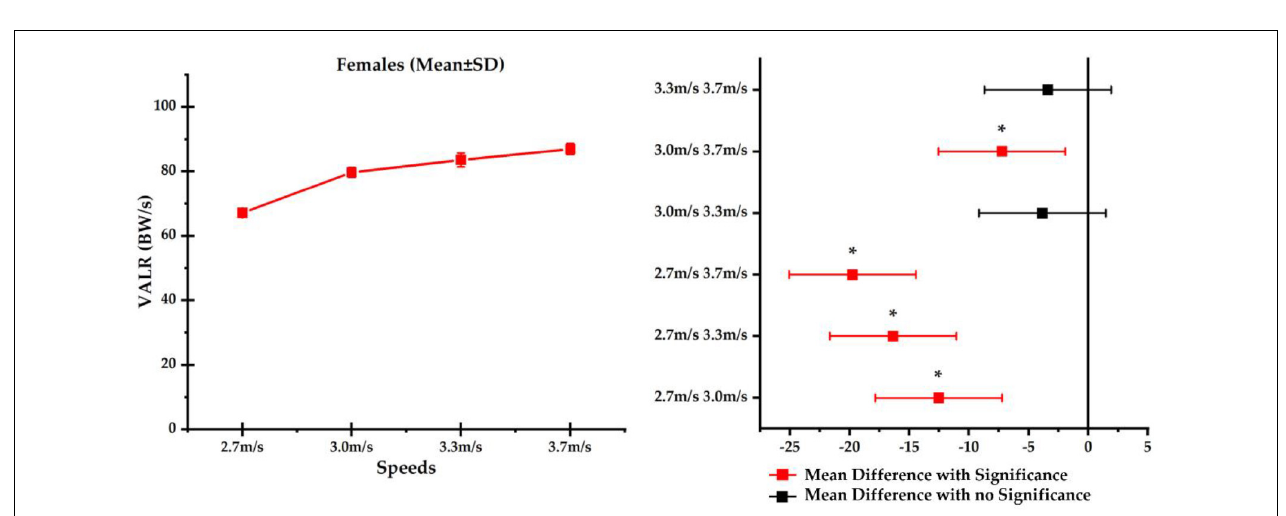
FIGURE 3 | Comparison of vertical average loading rates (VALRs) across different running speeds (mean ± SD), (left) and mean difference (right) in male runners with significance highlighted in blue and asterisk (*).